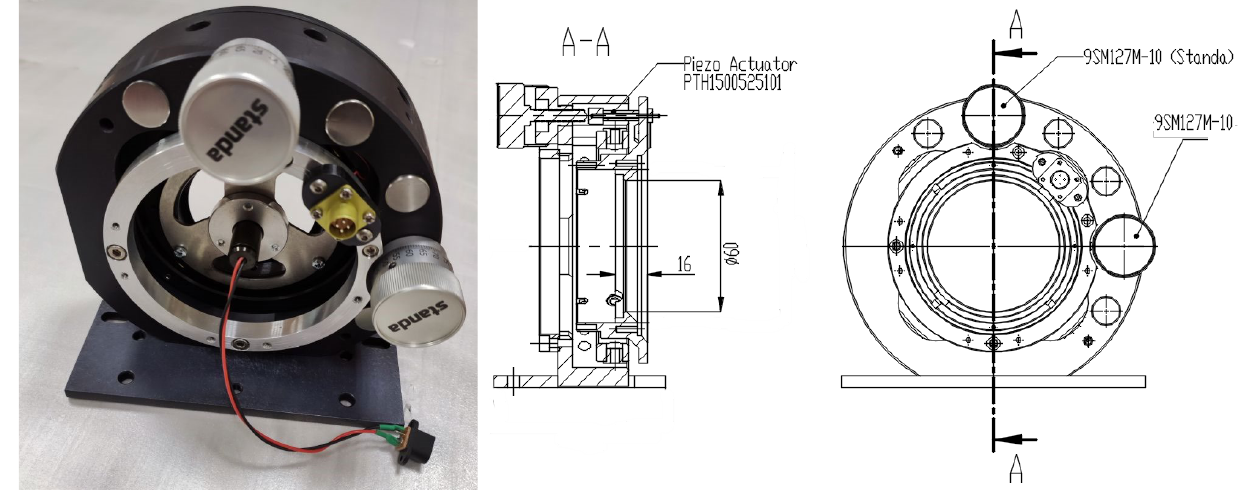
Figure 6. Photo and drawings of the tip-tilt mirror.